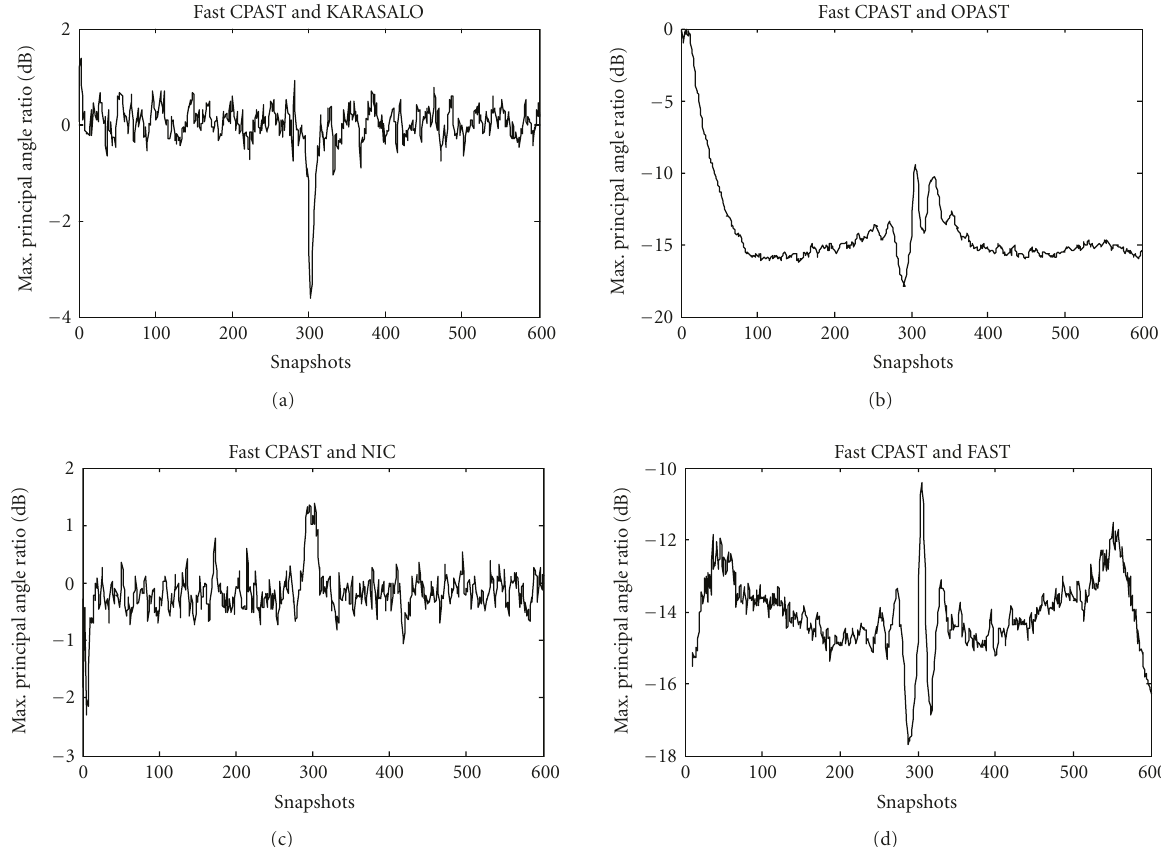
Figure 5: Ratio of maximum principal angles of fast CPAST and several other algorithms in the second simulation scenario.